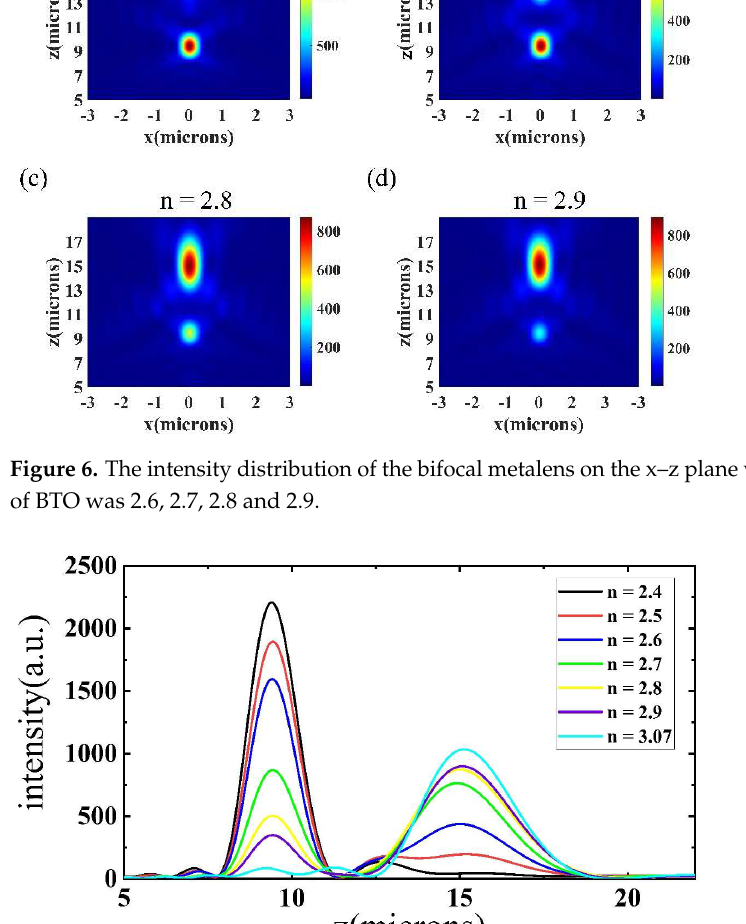
Figure 6. The intensity distribution of the bifocal metalens on the x–z plane when the refractive index of BTO was 2.6, 2.7, 2.8 and 2.9.